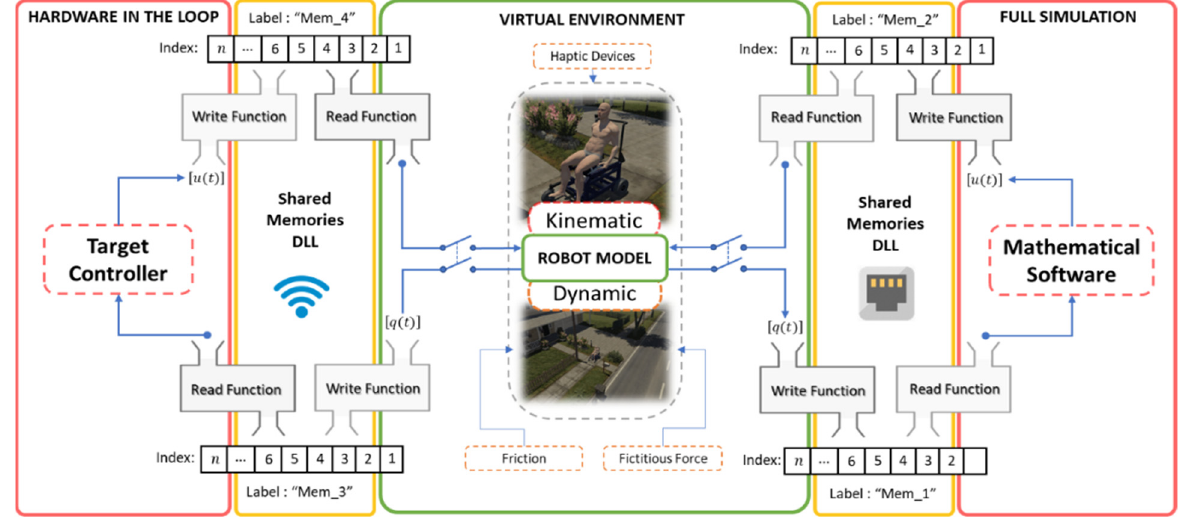
Figure 11. Data exchange between virtual environment and destination controller.